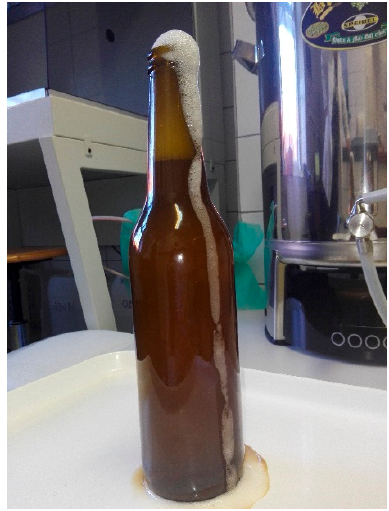
Figure 3. Permanent haze and gushing [21].